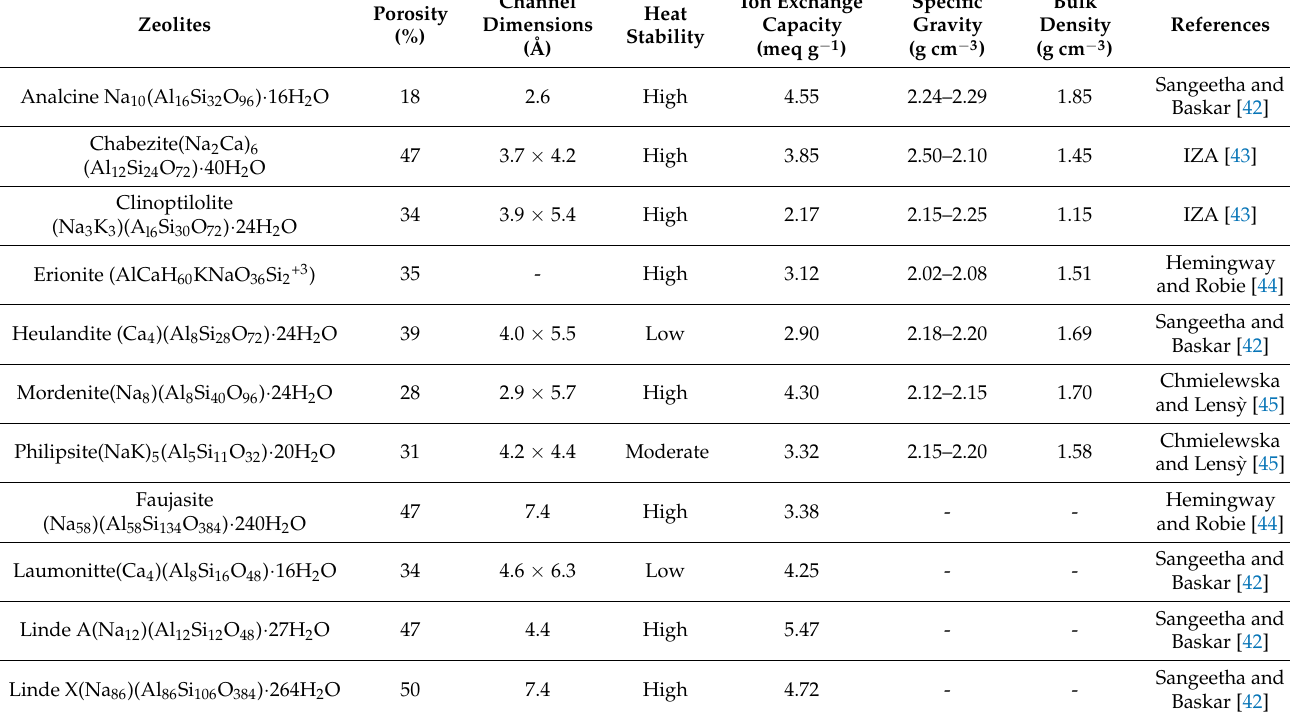
Table 1. Physical Characteristics of Some Naturally Occurring